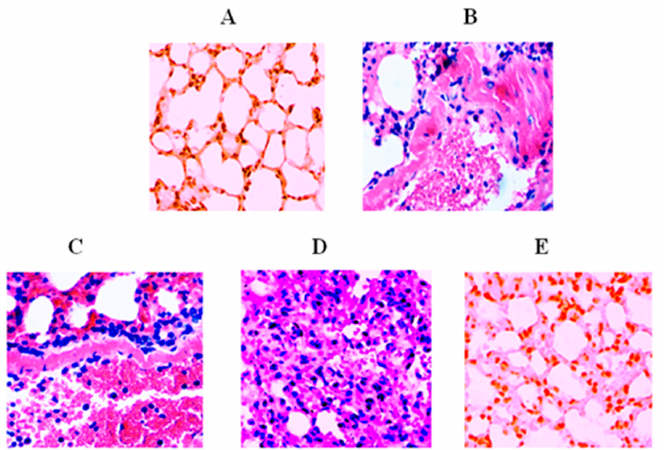
Figure 7. Treatment with Lip-TQ alleviated A. baumannii -associated pathological alterations in the lung tissues of infected mice. Histological study of the lung tissues of mice in the following groups: ( A ) uninfected normal control, ( B ) infected saline treatment, ( C ) infected sham liposome treatment, ( D ) infected free TQ-10 mg/kg treatment, and ( E ) infected Lip-TQ-10 mg/kg treatment. The amplification factor was 200 ×